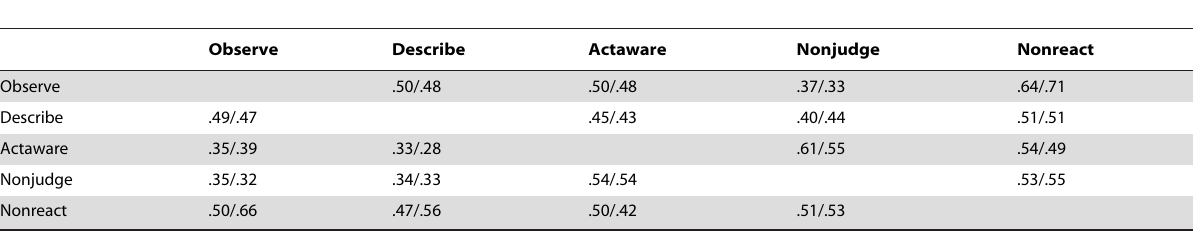
Table 5. Factor Intercorrelations in the Five-Factor Multigroup